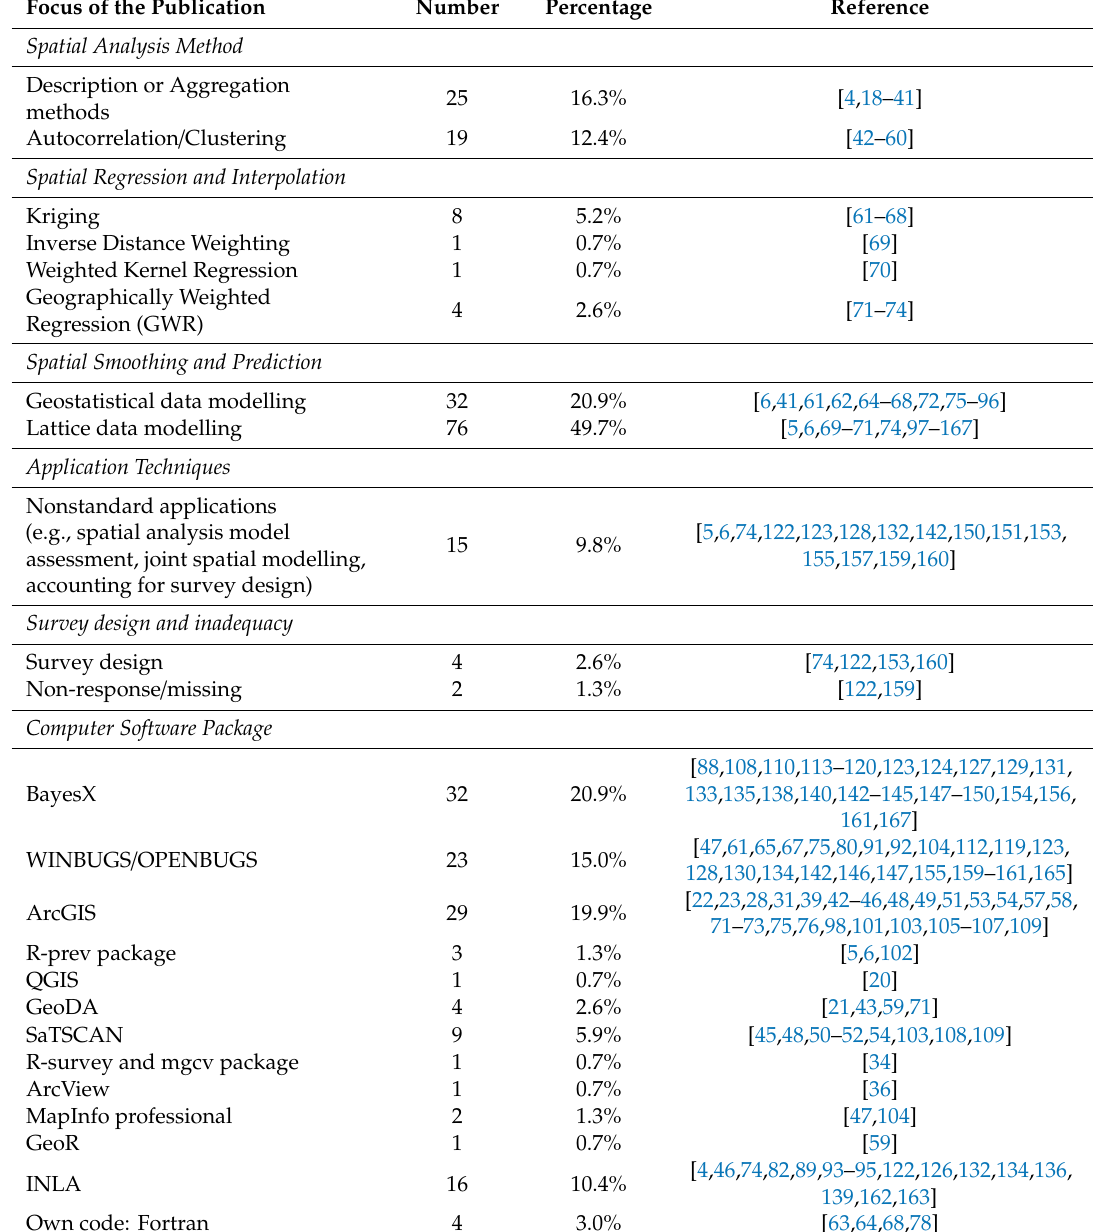
Table 1. Classification of the articles selected for review (n =